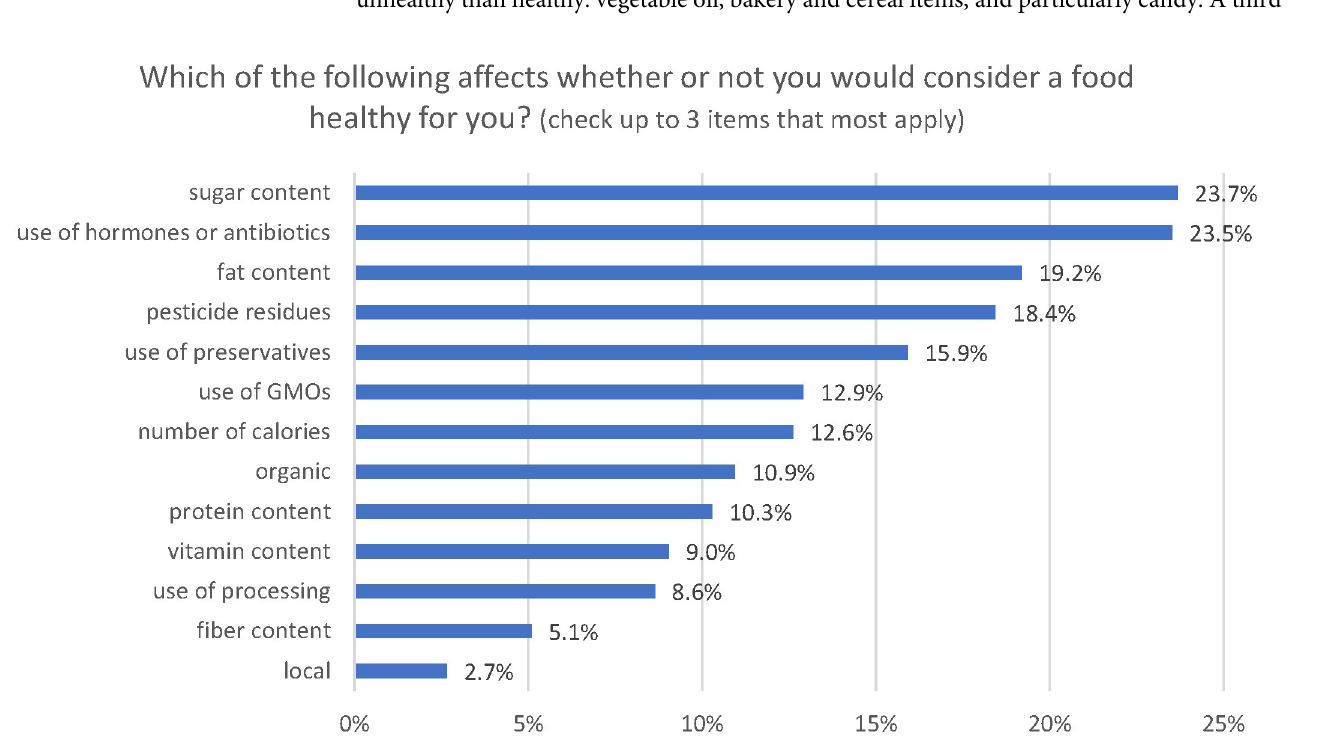
PLOS ONE | https://doi.org/10.1371/journal.pone.0223098 October 15,